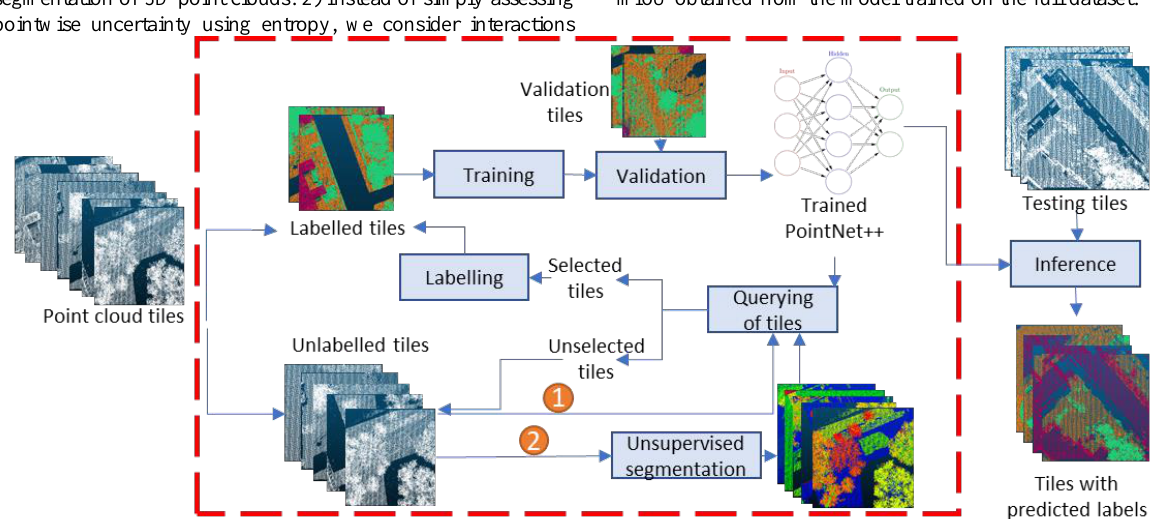
Figure 1. The proposed workflow for active learning strategy for semantic segmentation point cloud. Firstly, point clouds are split into tiles and separated into two groups: labelled (minority) and unlabelled (majority). Then, the network is trained on labelled tiles and the trained network selects segmented unlabelled tiles. Here two queries are tried. One query 1 directly consumes unlabelled tiles and the other one (query 2) relies on the unsupervised segmentation. Selected tiles are labelled before the next training. The trained network is evaluated on testing tiles in each